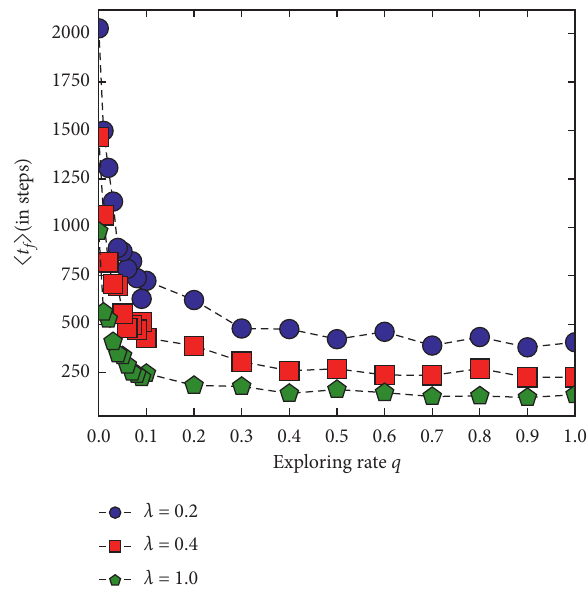
Figure 9: The average full prevalence time as a function of the exploring rate q versus the infection rate λ . The temporal networks are generated by the MD model with N � 1000, A � 1, α � 1, c � 1 . 6, P � 0 . 1, L � 40, T � 3000, and s is sampled from F ( s ) � IA ) − β with β � 2 . 8 and s � 1. The simulation result is the ( s / s min min average of 200